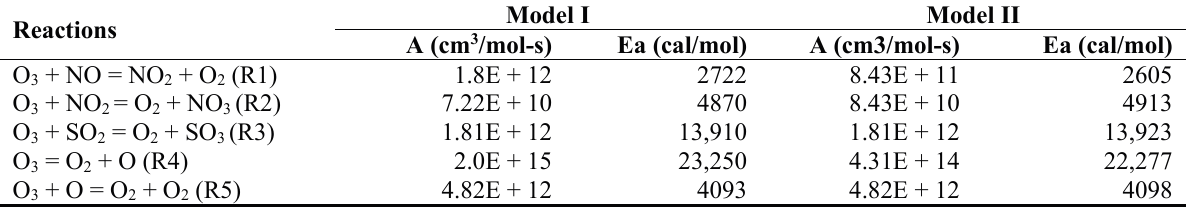
Table 1. Comparisons of parameters for key reactions of Model I and Model